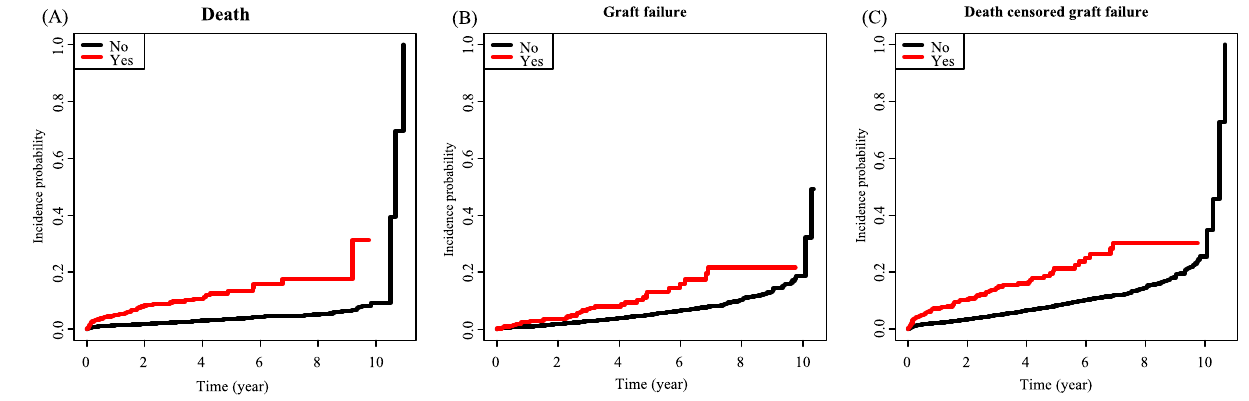
Figure 4. Cumulative risk for death, graft failure, and death censored graft failure according to presence of incident depression in KT group (( A ): death, ( B ): graft failure, ( C ): death censored graft